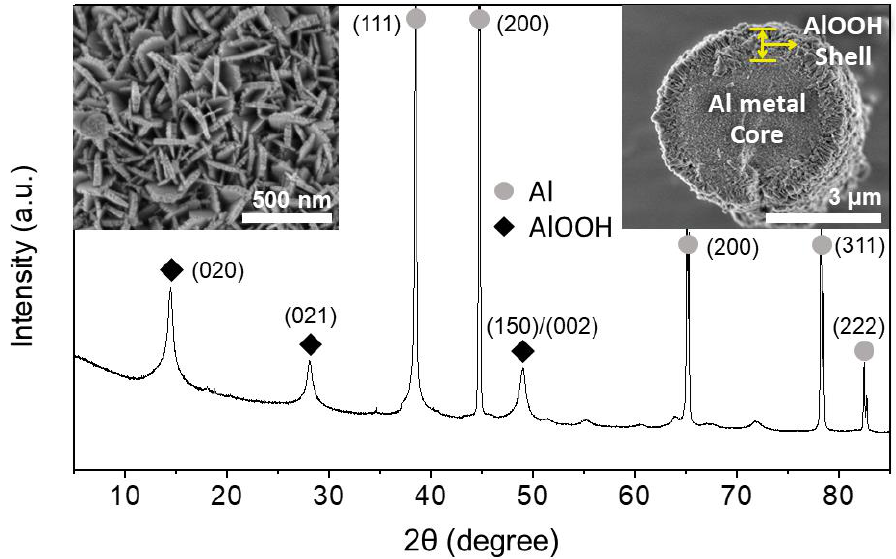
Figure 1. XRD pattern and SEM micrographs (insets: surface morphology ( left ) and cross-section ( right )) of the Al@AlOOH core–shell prepared by HTR of Al metal particles at 373 K for 5 h. Aluminum hydroxide is amphoteric with increasing solubility in an aqueous solu- tion both in acidic and basic conditions [17]. Therefore, the synthesis of Al@AlOOH was the pristine Al and Al@AlOOH core–shell samples prepared in D.I.-H 2 O (pH = 7.2)